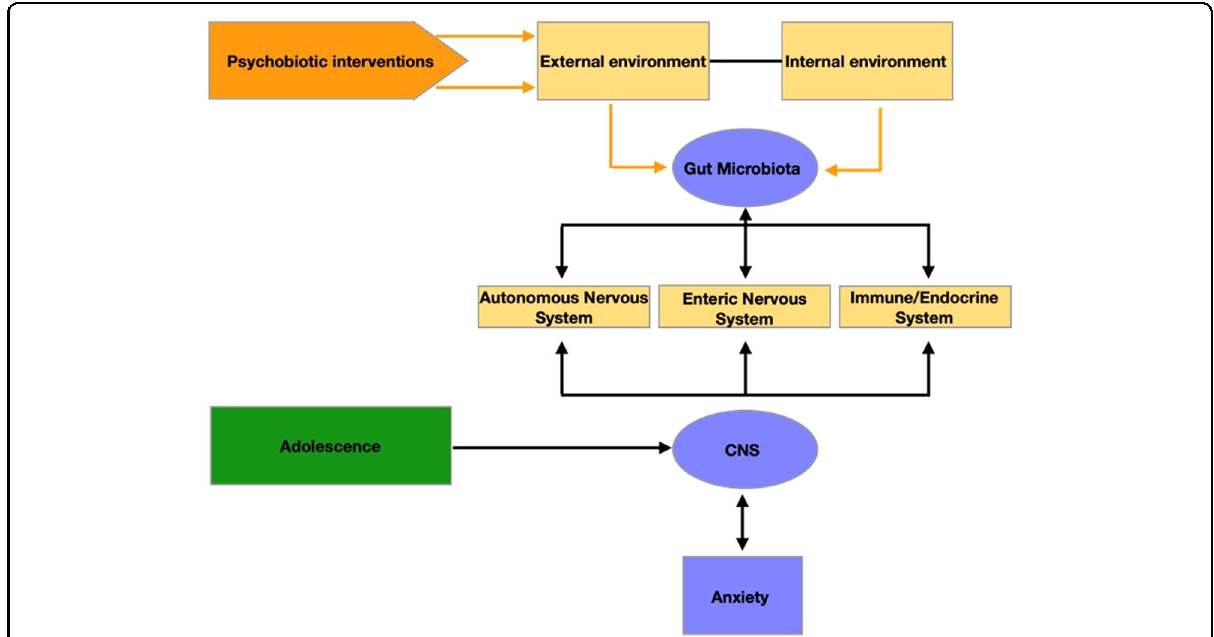
Fig. 1 Proposed intervention pathway for the active ingredient. Adolescence is a time period of ongoing neuro-cognitive development, allowing brain structures and circuities to fl exibly adapt- or maladapt to the environment. In this context, gut microbiota might play be a causal role as a mediator between the environment and the CNS via multiple pathways. As easily manipulated throughout diet, it could be a promising and cheap therapy target in the redirection of neurodevelopmental trajectories and improving the mental health outcome for the